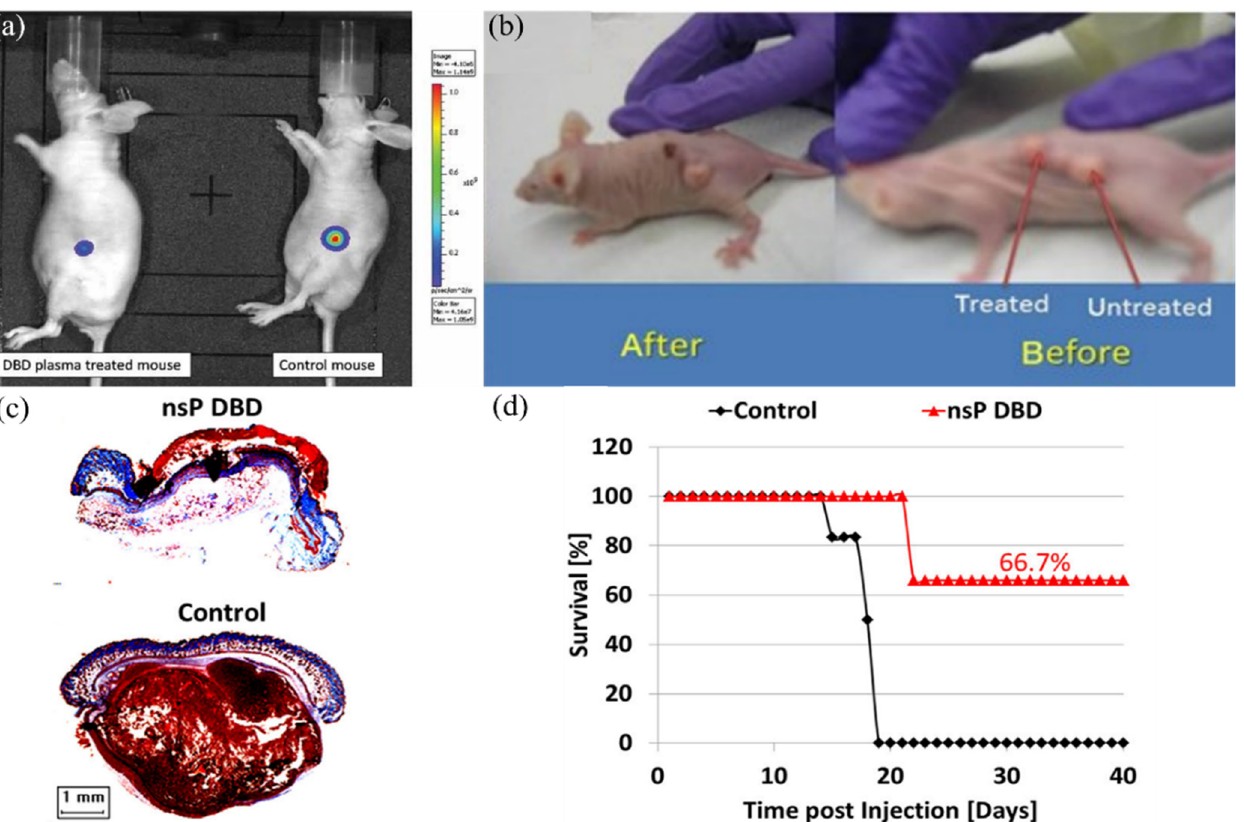
Figure 2. Some representative anti-tumor demonstrations use subcutaneous models. ( a ) U87 xenografted nude mice mouse was irradiated (6 min) by a DBD device for 5 consecutive days. Bioluminescence imaging (BLI) was used to quantify tumor growth and size. Reprinted with permission from Ref. [53]. 2010, Wiley. ( b ) Typical image of mice with three subcutaneous Bladder xenografted tumors before and 24 h after APPJ treatment. [49]. ( c ) nsp DBD treatment strongly eradiated melanoma tumors in mice. Trichrome staining of DBD treated tumor (top) and control tumor (bottom). ( d ) Survival for DBD treated tumors (red) and untreated tumors in control (black) as a function of time post-injection. [48].